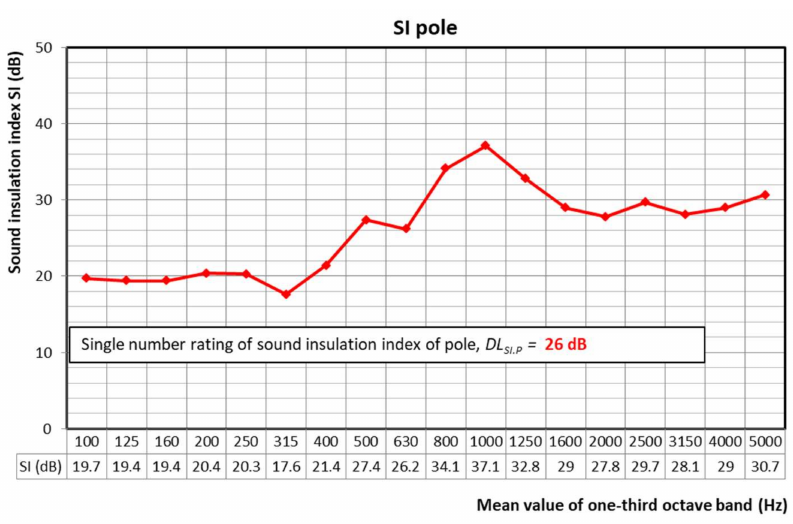
Figure 15. Diagram from the measurement of the airborne sound insulation index of a pole.